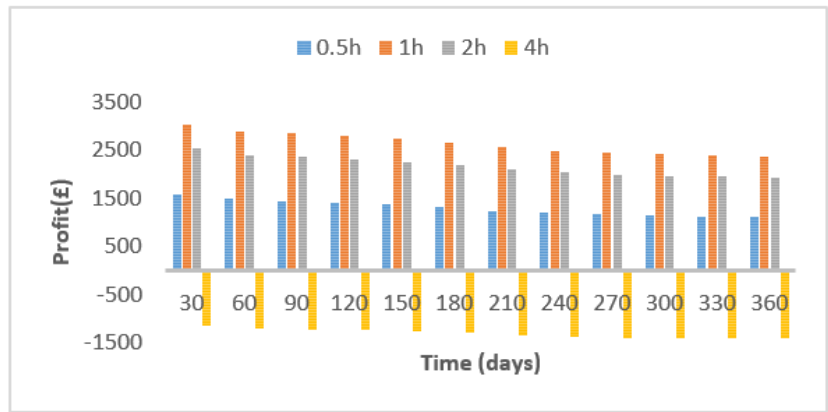
Figure 13. Profitability of the four de-rated batteries over 1 year with an increase in shortage events.